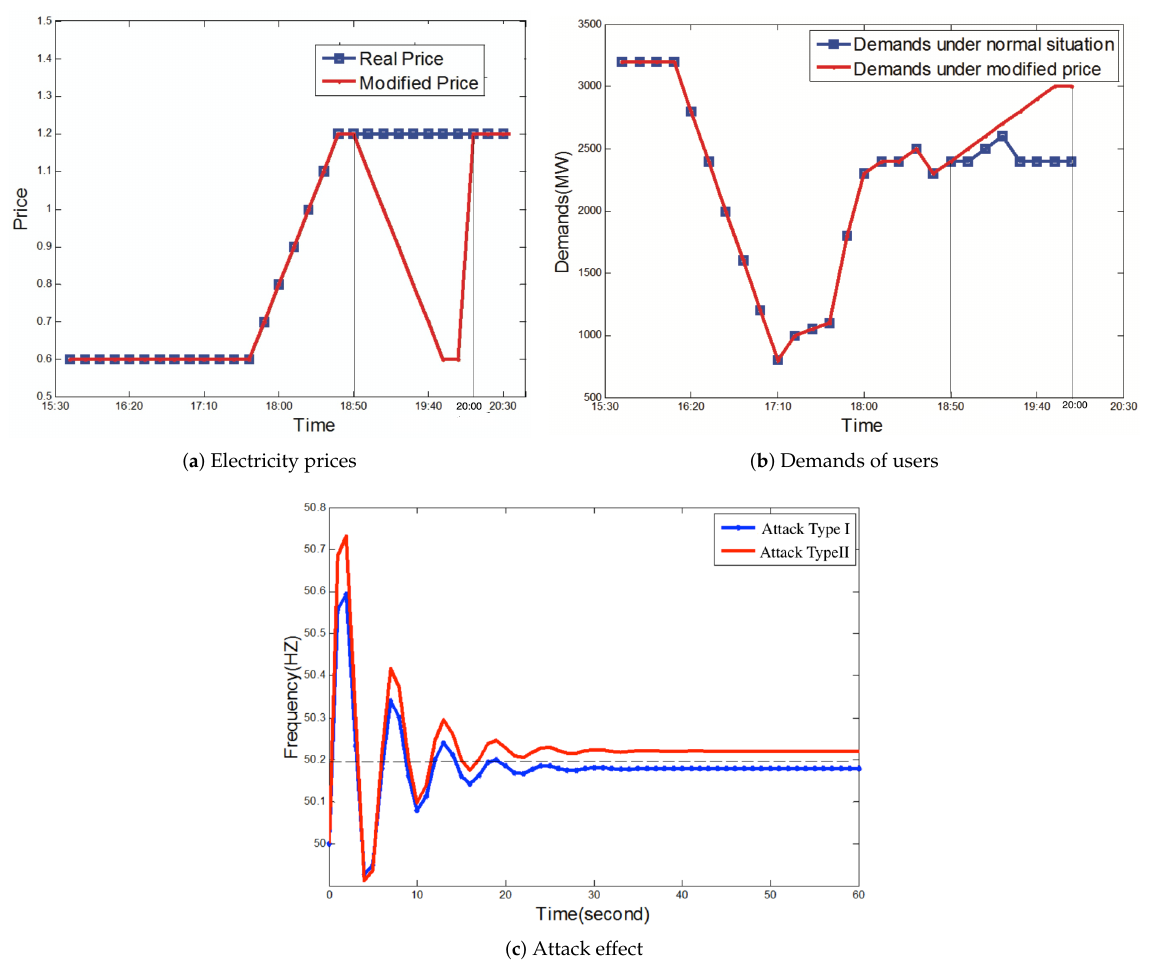
Figure 16. Comparing the attack effects between Attack Type I and Attack Type II, where α = 0.5 and initial demands = 2400